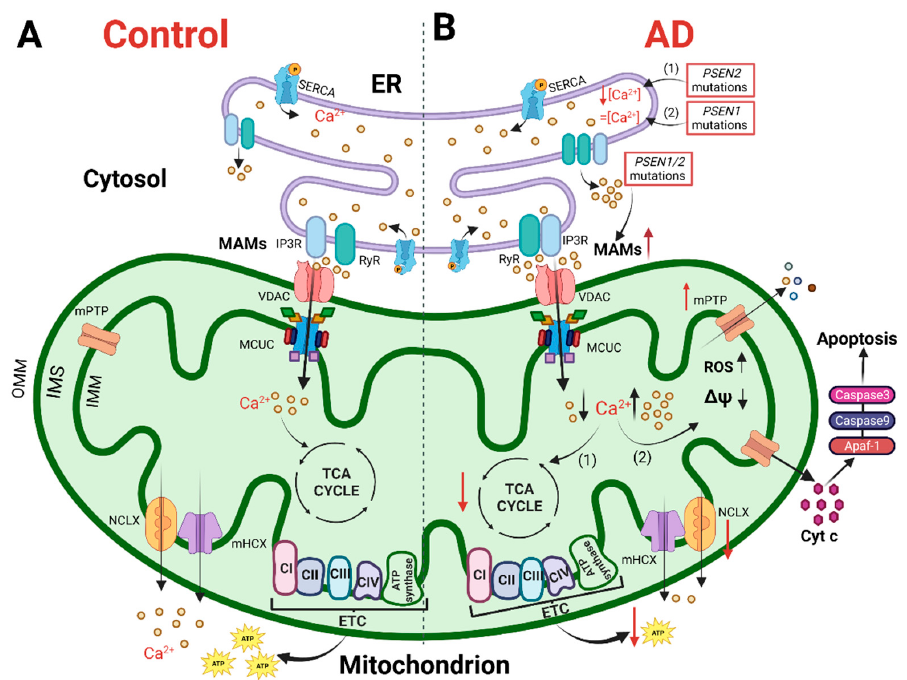
Figure 1. The cartoon shows mitochondrial Ca 2+ handling and Ca 2+ -dependent bioenergetic functions in both physiological conditions (left) and AD (right). ( A ) In physiological conditions, the Ca 2+ cross-talk between ER and mitochondria at MAMs, mediated by Inositol 1,4,5-trisphosphate receptors (IP3R) and ryanodine receptors (RyR) on the ER and VDAC and mitochondrial Ca 2+ uniporter (MCU) complex (MCUC) on mitochondria, regulates mitochondrial Ca 2+ entry, sustaining the TCA cycle and ATP synthesis. ( B ) In AD, various Ca 2+ alterations have been reported. (1) Mutations in PSEN2 cause a reduction in the ER Ca 2+ content, whereas (2) mutations in PSEN1 do not alter the ER Ca 2+ content. Mutations in PSEN1/2 , by increasing the open probability of ER Ca 2+ releasing channels, cause an excessive release of Ca 2+ from this store. Both a mitochondrial Ca 2+ overload and blunted mitochondrial Ca 2+ uptake ability have been described. The first stimulates a sustained production of ROS, the opening of mitochondrial permeability transition pore (mPTP) and the release of cytochrome c activating the apoptotic pathway. The second causes a decrease in ATP production, leading to a bioenergetic crisis. This original figure was created by the authors using “BioRender.com” (https://biorender.com, accessed on 7 November